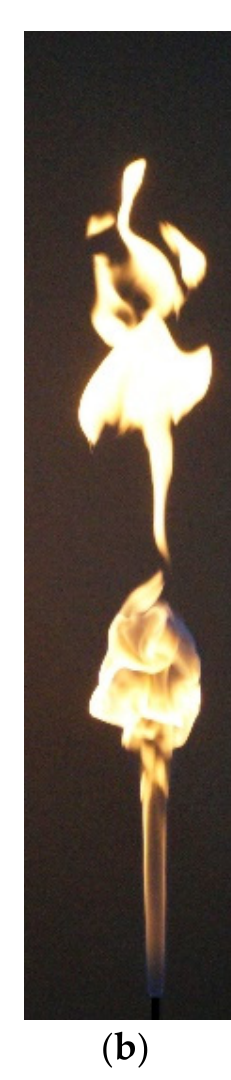
Figure 9. Methane diffusion flame, Re = 2312, d = 3 mm, L = 1 m. Unperturbed flow ( a ), emanation of puffs ( b ).